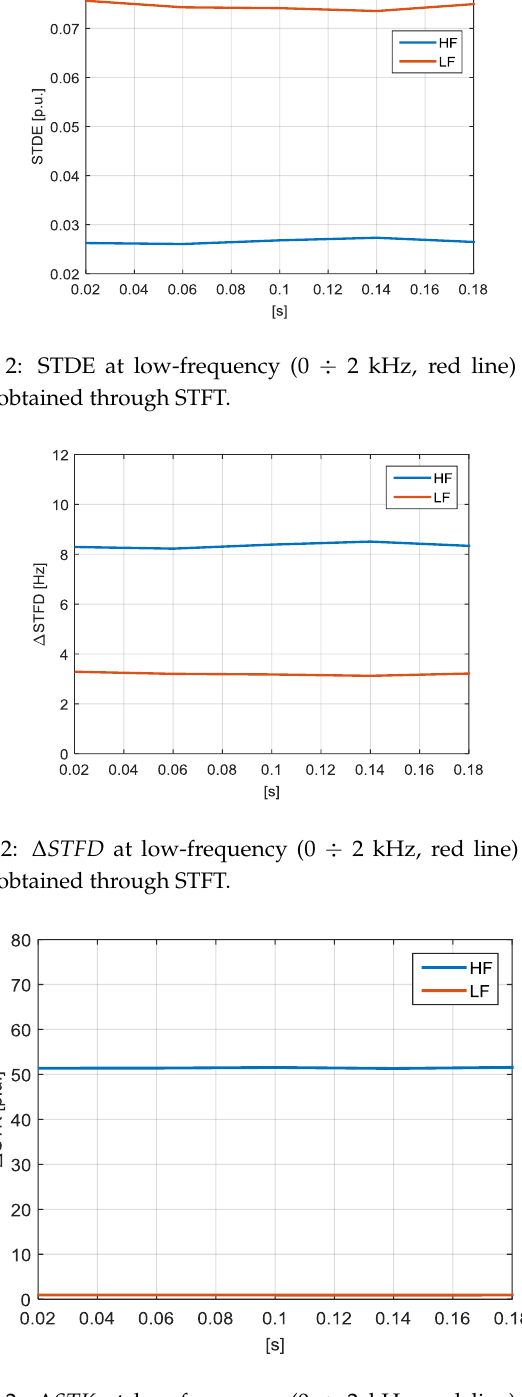
Figure 34. Case study 2: STDE at low-frequency (0 ÷ 2 kHz, red line) and at high-frequency (2 ÷ 150 kHz, blue line) obtained through Prony’s method. Figure 35. Case study 2: Δ STFD at low-frequency (0 ÷ 2 kHz, red line) and at high-frequency (2 ÷ 150 kHz, blue line) obtained through Prony’s method.